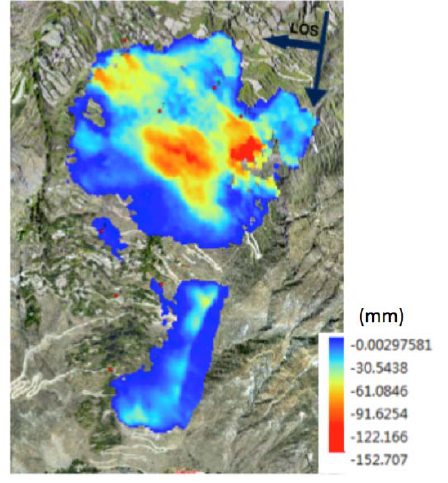
Figure 3. Landslide deformation velocity map